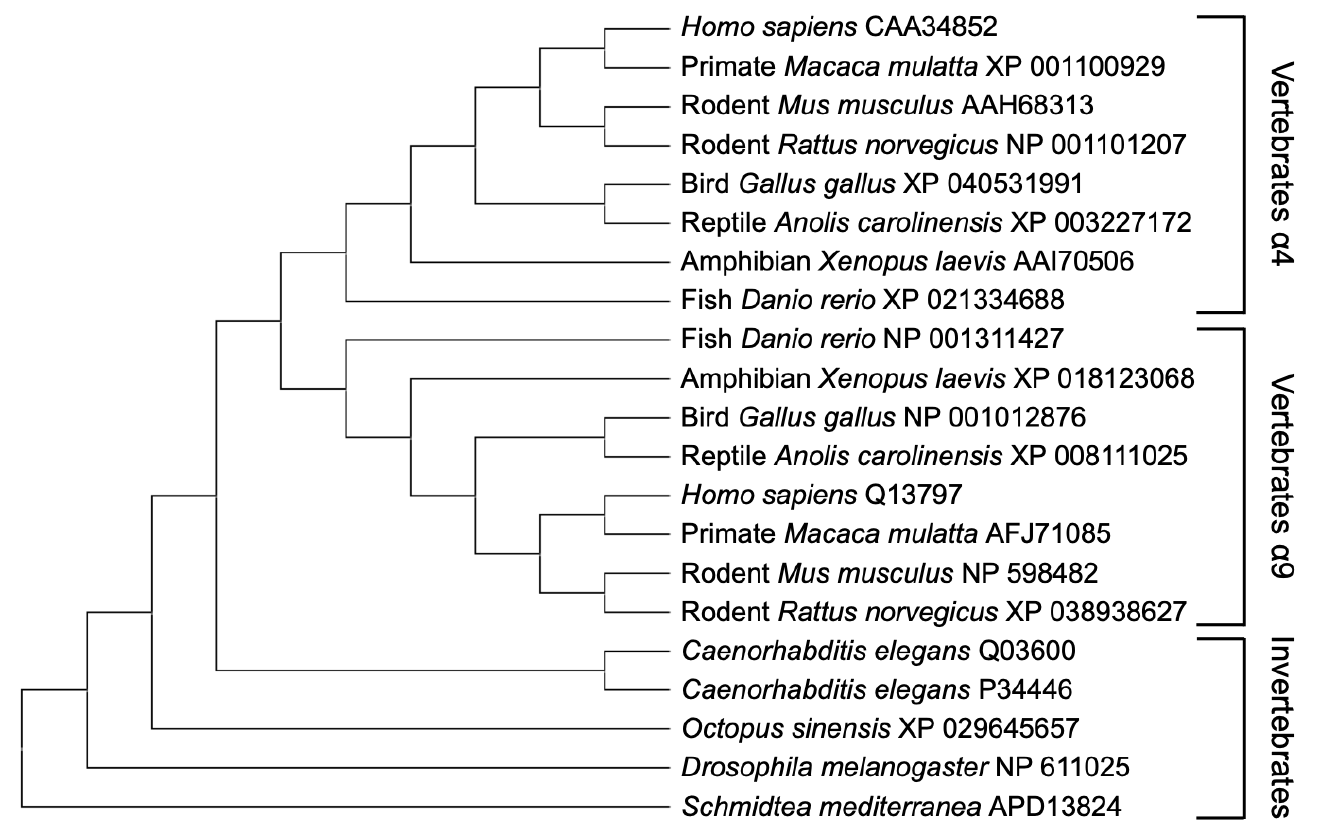
Figure 1. Phylogenetic relationship of PS4 integrin group. Protein sequences of the vertebrate integrins α 4 and α 9 and invertebrate integrins ( α ina-1 and pat-2 of Caenorhabditis elegans , α 4 of Octopus sinensis , α PS4 of Drosophila melanogaster , and α int-4 of Schmidtea mediterranea ) obtained from the NCBI were aligned using the ClustalW algorithm, and a phylogenetic tree was drawn with Neighbor-Joining on MEGA11 [33]. Johnson et al. [24] divided the vertebrate and invertebrate animal β integrins into three clusters, namely, vertebrate A ( β 1, 2, and 7), vertebrate B ( β 3, 4, 5, 6, and 8), and invertebrate